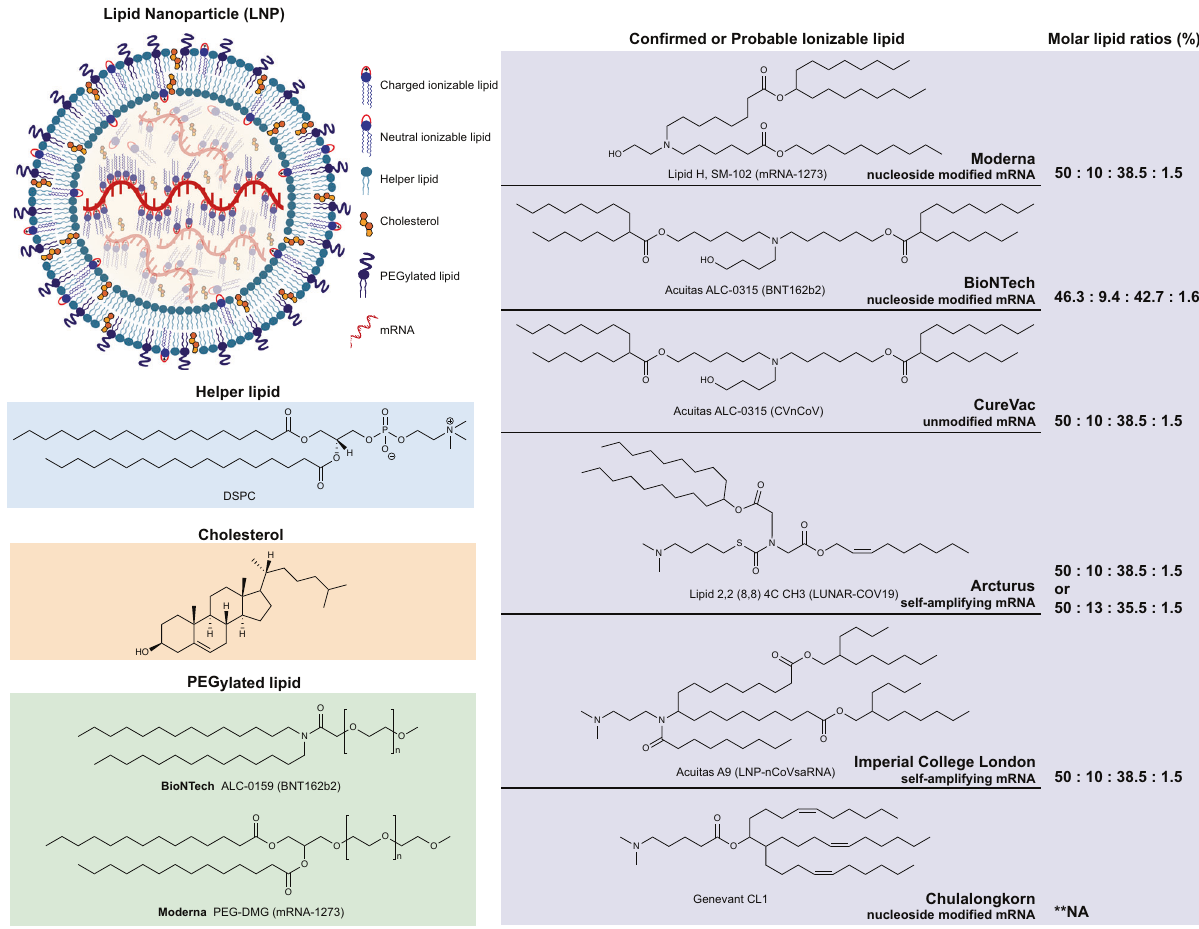
Fig. 7 Structure of lipid nanoparticles (LNPs) and lipid components employed in currently available COVID-19 mRNA vaccines. LNPs are composed of four components: ionizable lipid, helper lipid, cholesterol, and PEGylated lipid. Binding with mRNA occurs by the ionizable lipid that occupies the central core of the LNP. PEGylated lipid is found on the surface of LNPs along with helper lipid forming the bilayer. Cholesterol, charged ionizable lipids, and neutral ionizable lipids are distributed throughout LNPs. The con fi rmed or the most likely chemical structure of ionizable lipids employed in COVID-19 mRNA vaccines developed by Moderna, BioNTech, CureVac, Arcturus, Imperial College London, and Chulalongkorn University. 289 *Molar lipid ratio (%) of ionizable lipid: helper lipid: cholesterol: PEGylated lipid; ** NA : Not applicable an adjuvant effect, and cationic lipids on the surface of the lipid shell Moreover, this LPP-based mRNA vaccine exhibited intrinsic can bind to mRNA by electrostatic adsorption. The Lipid InOrganic adjuvant activity, which stimulates dendritic cells (DCs) to secrete cytokines and inhibit tumor growth by activating the TLR7/ 8 signaling pathway, resulting in a signi fi cant antitumor activity. Yang and colleagues 330 applied similar LPP technology to encapsulate mRNA in two steps using ionizable lipid, DOPE and PEG-lipid to generate COVID-19 mRNA vaccine with a core-shell structure, which showed signi fi cant protection in mice and non- human primates. In addition to lipid and polymer carriers, peptides can also be used for mRNA delivery. 331 – 333 Since some amino acids carry cationic or amphiphilic amino groups, they can electrostatically bind mRNA to form nanocomplexes. A commercial peptide, PepFect14, was shown to effectively deliver therapeutic mRNAs to ovarian tumor cells in mice. 334 In addition, protamine was shown to activate TLR7 and TLR8 pathways, thereby showing potential as a delivery vehicle with adjuvant effect for vaccines or gene therapy. 188 Based on this observation, the protamine-containing delivery platform developed by CureVac has been used in various vaccines and gene therapy for cancer treatment. 85,335 Finally, cationic squalene emulsions can be (Table 3). The mRNA vaccine BNT111 developed by BioNTech ’ s applicable for mRNA delivery. 336,337 These nanoemulsions are FixVac platform to treat advanced melanoma has entered phase II clinical trials and was assigned the FDA Fast Track designation on composed of a squalene-based core and a lipid shell. Squalene has Signal Transduction and Targeted Therapy (2022)